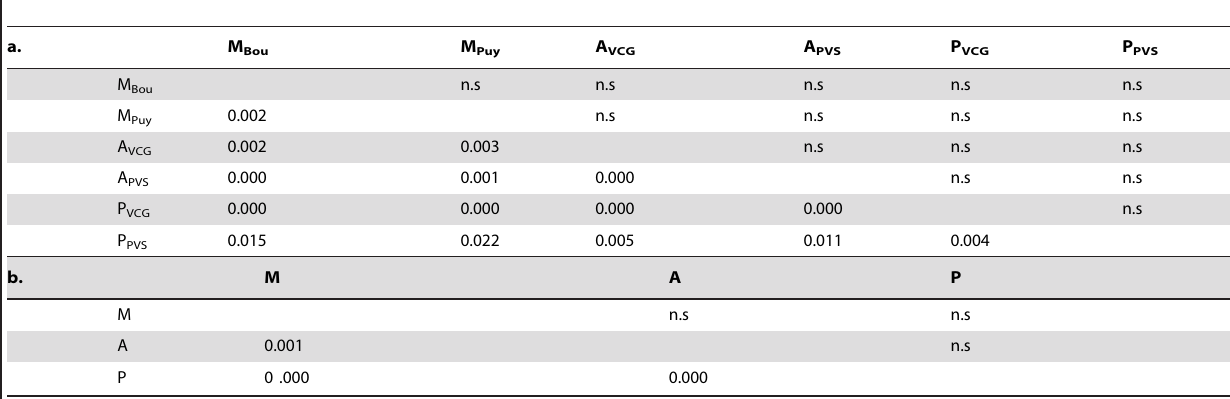
Table 3. Pair-wise F-statistics (F ST ) between sampling groups (a.) and overwintering strategies (b.).